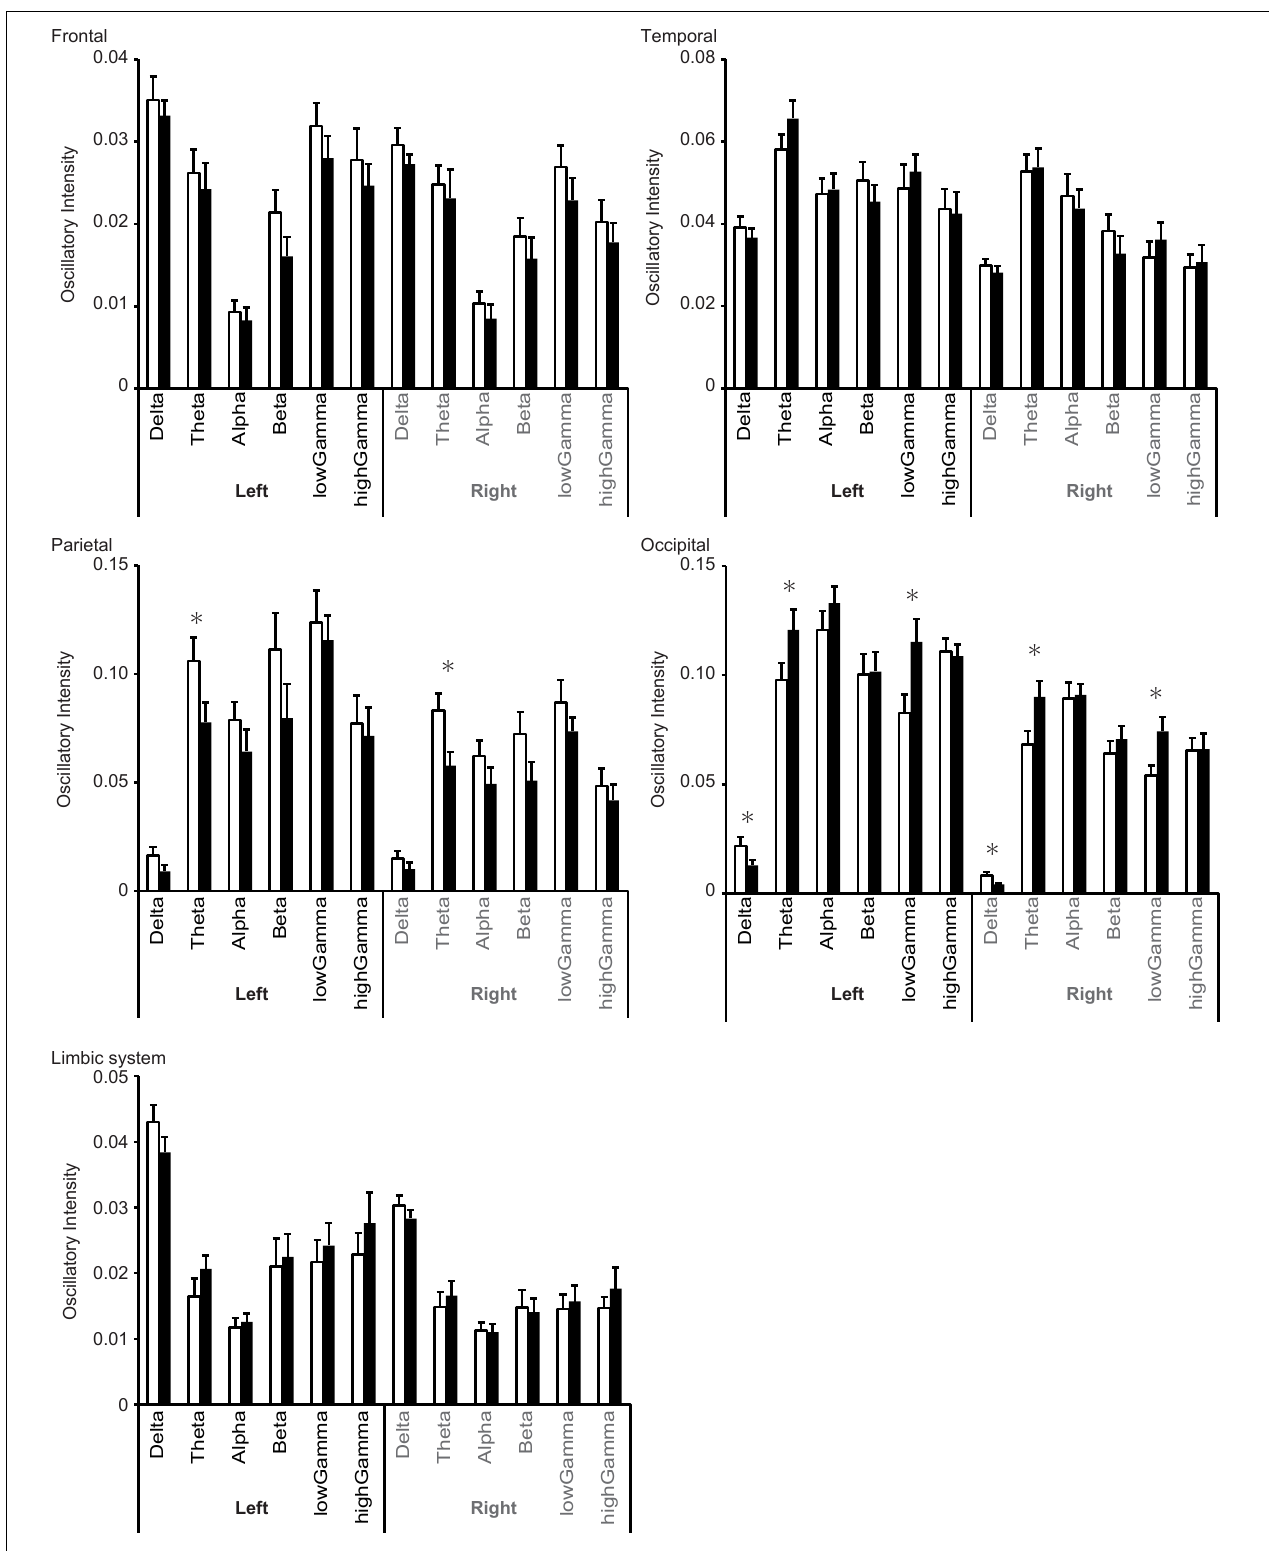
FIGURE 6 | Changes in regional oscillatory intensity during the proliferative (open columns) and secretory (filled columns) phases. Error bars represent the grand mean of standard errors over bootstrapped iterations, whereas asterisks (*) indicate statistically significant differences (after false-discovery rate (FDR) correction).